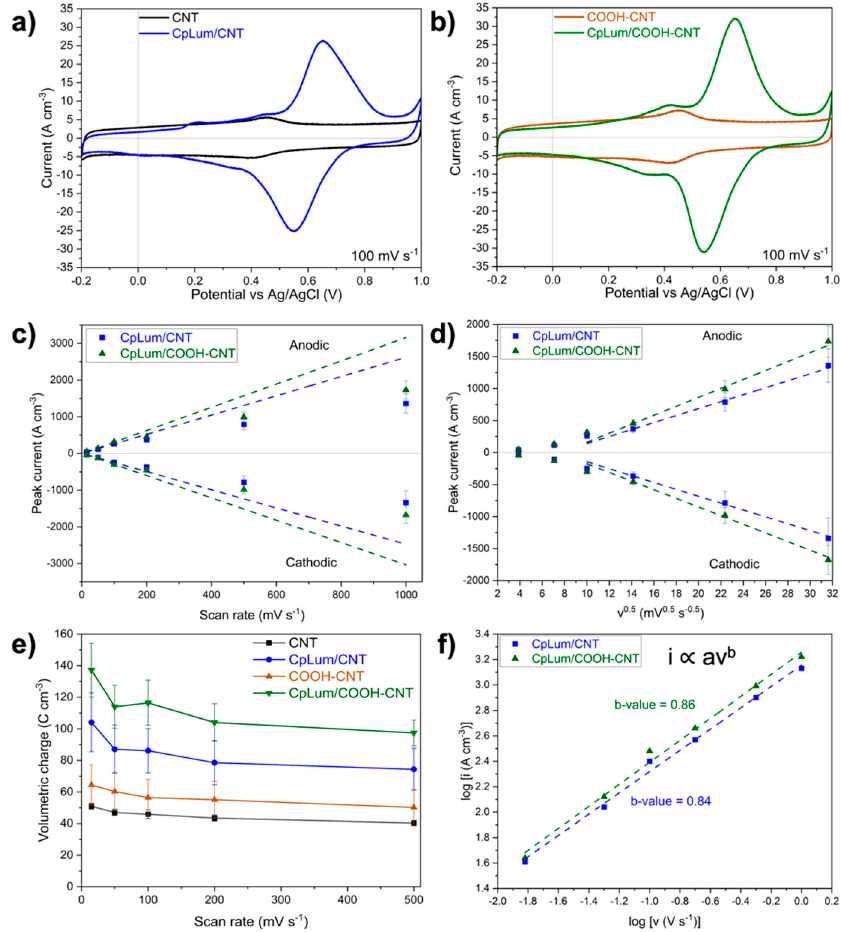
Figure 6. Cyclic voltammograms of ( a ) CNT vs. CpLum/CNT, ( b ) COOH-CNT vs. CpLum/COOH- CNT, peak currents varying across ( c ) scan rate, v and ( d ) v 0.5 , ( e ) rate performance for CNT, CpLum- CNT, COOH-CNT and CpLum/COOH-CNT, ( f ) log cathodic peak current vs. log v plot revealing cathodic b-values for CpLum/CNT and CpLum/COOH-CNT.